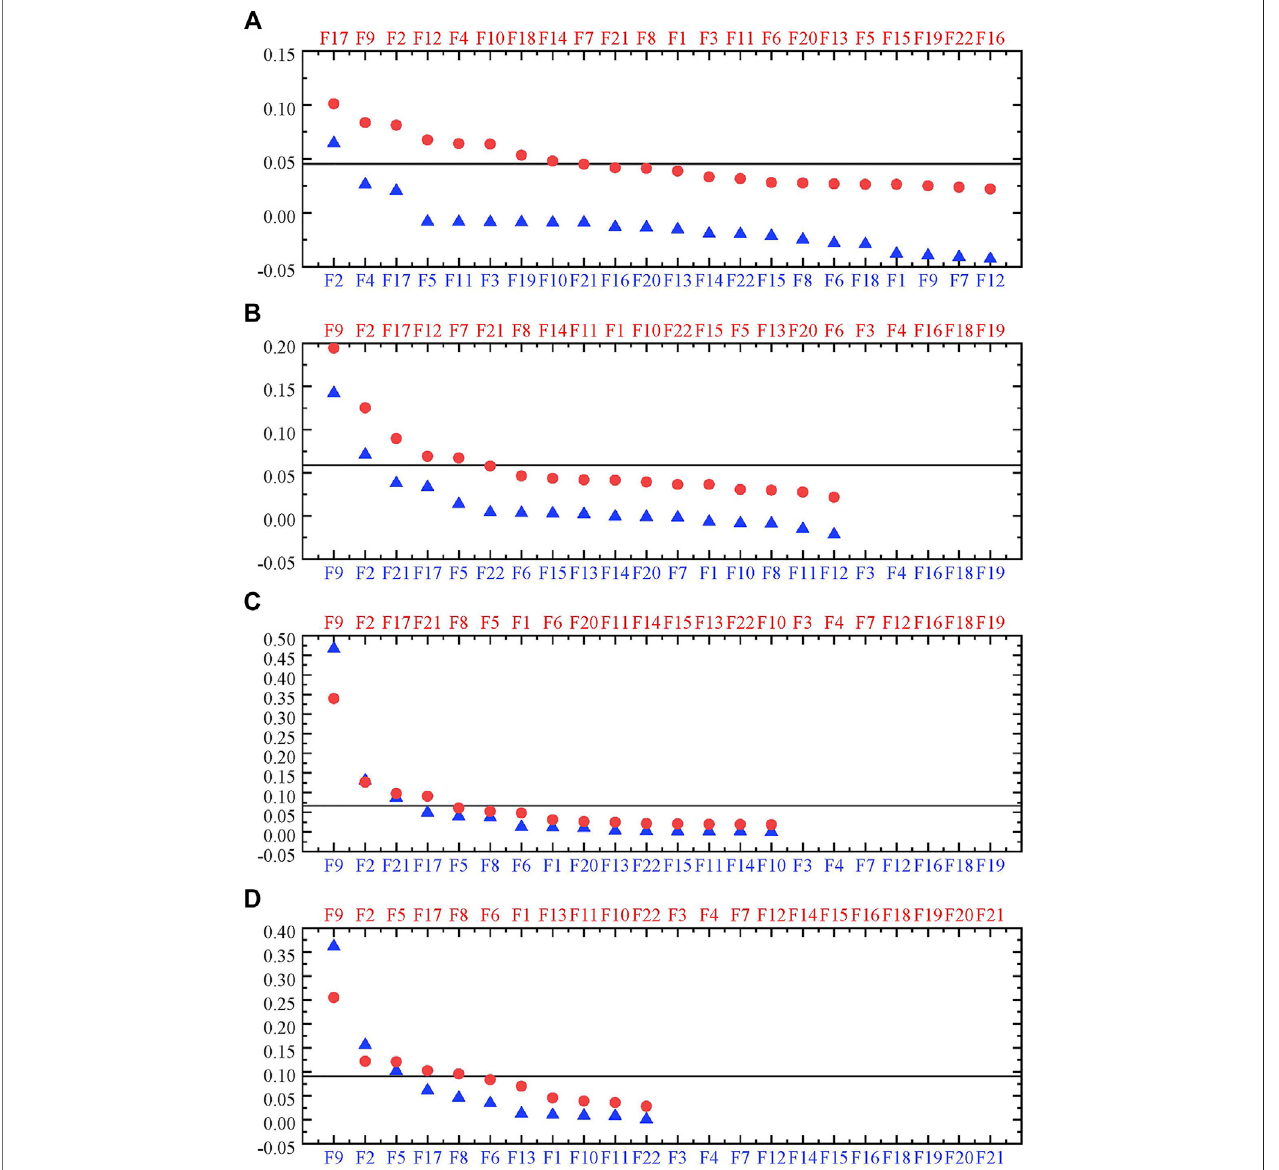
FIGURE 8 | Rank plots are provided in descending order with features exhibiting maximum importance on the leftmost in case of drought-affected area based on datasets of (A) 2011 – 2019, (B) 2004 – 2019, (C) 1987 – 2019, and (D) 1979 – 2019. Red circles and top x -axis represent results derived from Gini importance, blue triangles and bottom x -axis represent results derived from permutation feature importance. The line shows the average feature importance, which can be used as a threshold to determine the signi fi cant features of interest for Gini